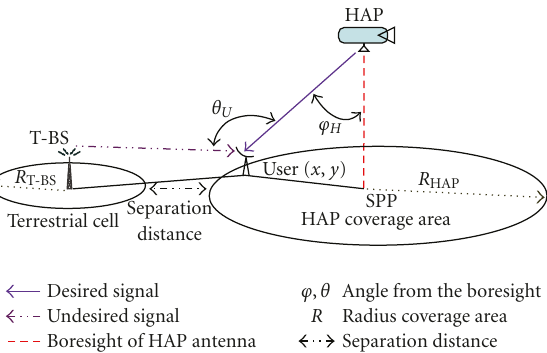
Figure 2: CDF of CNR performance with isotropic and directive antenna